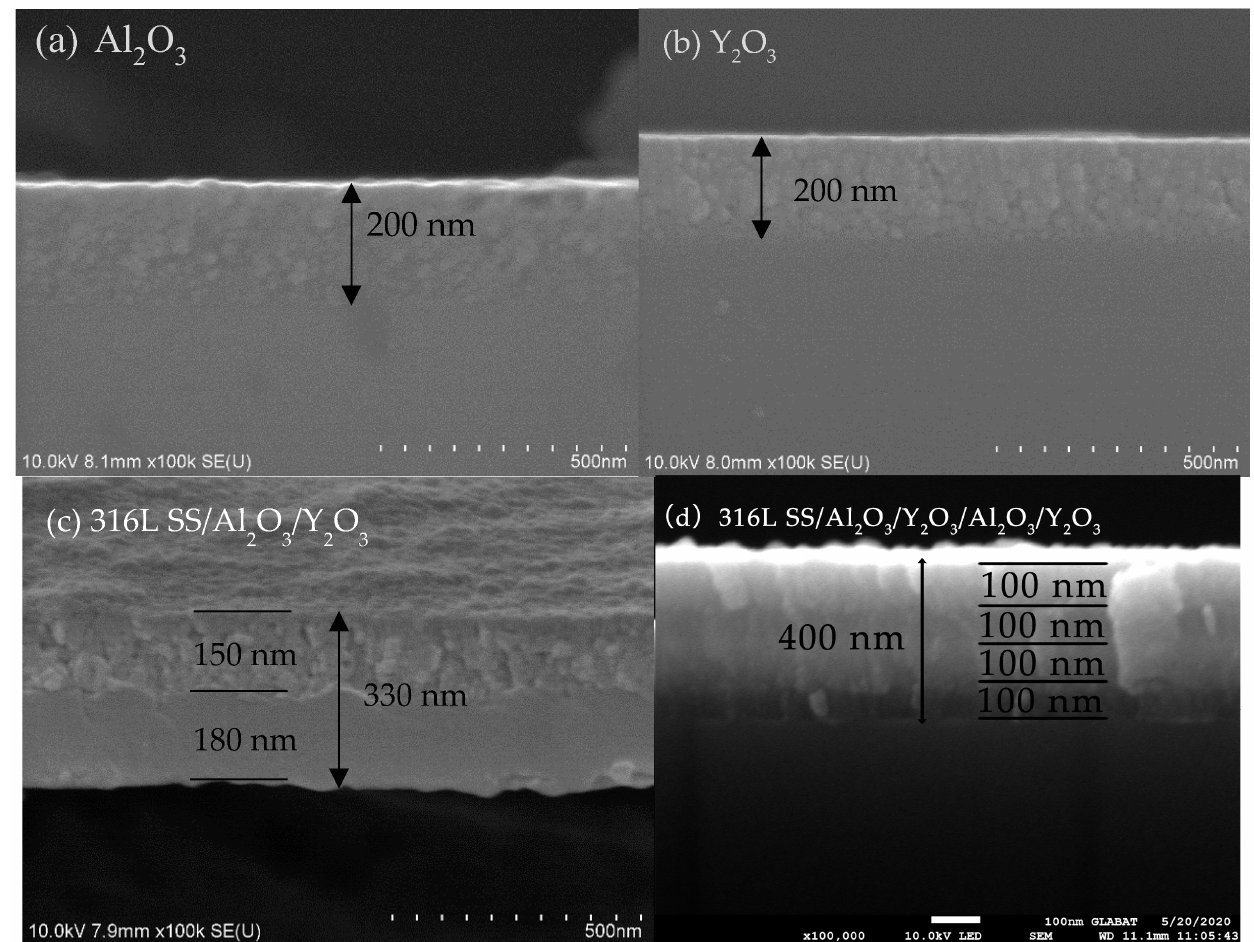
Figure 2. SEM images of the nanoscale coatings: ( a ) Al 2 O 3 [32]; ( b ) Y 2 O 3 [34]; ( c ) 316L SS/Al 2 O 3 /Y 2 O 3 [32]; ( d ) 316L SS/Al 2 O 3 /Y 2 O 3 /Al 2 O 3 /Y 2 O 3 .